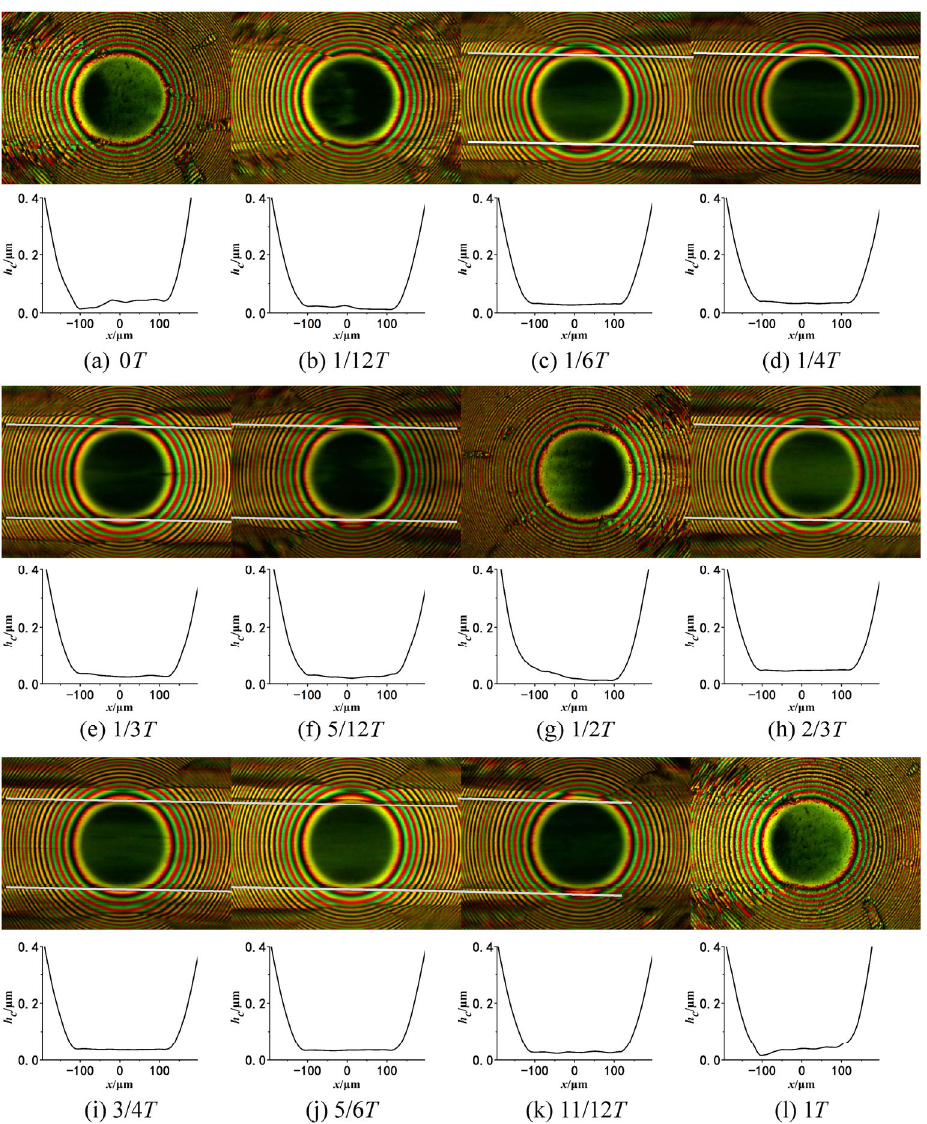
Fig. 21 Interferograms and midsection film thickness during 200th cycle under pure rolling reciprocating motion ( v max = 0.1 m/s, w = 15 N, T = 0.5 s, L = 12.5